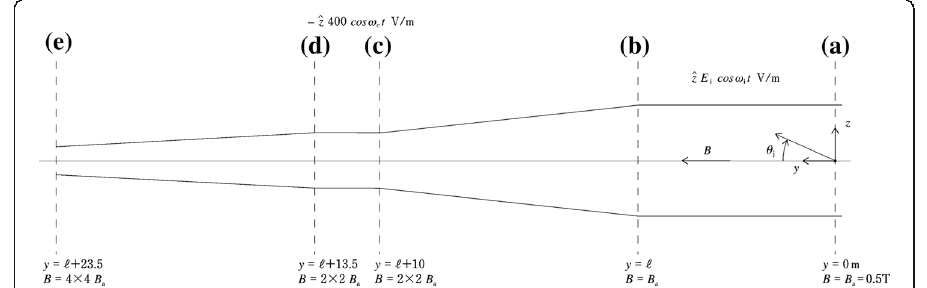
Fig. 7 A magnetic field configuration in the left-hand side of the exit of a main magnetic bottle, for reclaiming charged particles to escape from the exit (plane (a)). We first assumed the value of the magnetic field in plane (a) and the magnetic field configuration. After that we set the length and the value of the electric field between planes (c) and (d), based on Eq. (26). With respect to the magnitude 0.5 T of B in plane (a), we assumed the value so that the gyration radius of a D + ion with the mean thermal velocity 2×10 6 m/s may be nearly 0.1